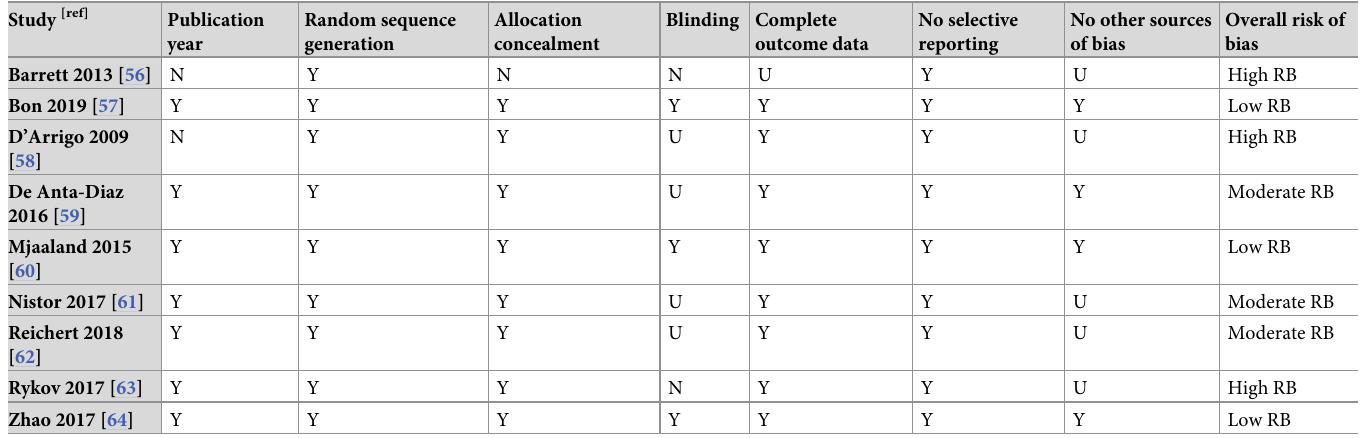
Table 2. Risk of bias assessment.